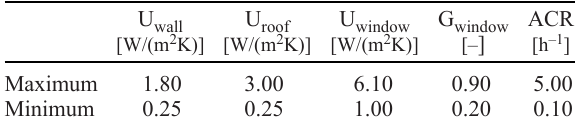
Table 1. Decision variables limits – variables space